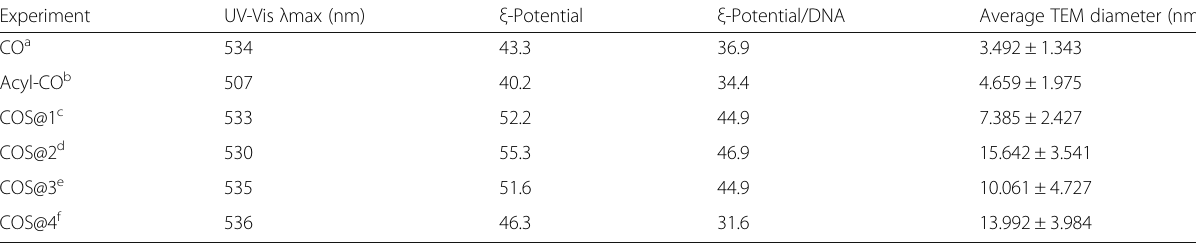
Table 2 Physical parameters summary